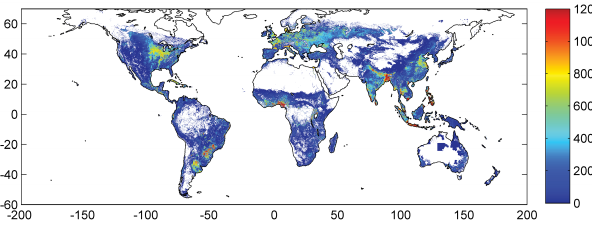
Figure 2. Spatial distribution of annual GPP flux (gCm − 2 yr − 1 ) for each 5arcmin grid cell in the year 2000 with values capped at 1200gCm − 2 yr − 1 . Annual GPP flux values of some grid cells in the tropics are larger than 2000gCm − 2 yr − 1